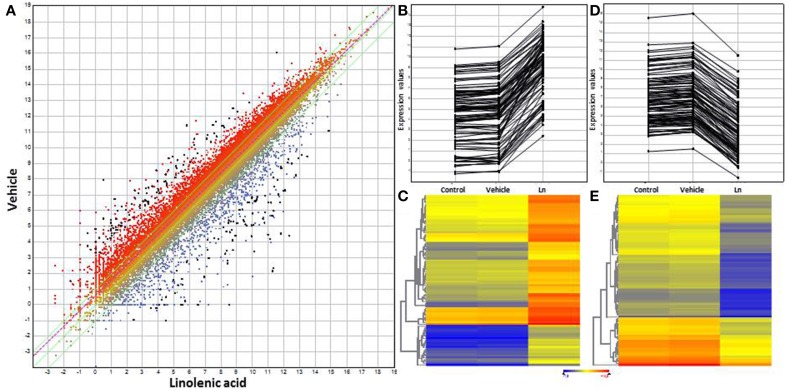
Scatter plot, line plot and heat map for 8-fold-change genes using DNAStar software. (A) Scatter plot of total Ln-responsive genes. (B) Line plot of overexpressed genes. (C) Heat map for overexpressed genes. (D) Line plot of repressed genes. (E) Heat map for repressed genes. Distilled water and methanol-responsive genes were used to filter the results of Ln treatment. All graphs show 8-fold-change genes with 95% significant differential expression obtained by t-student test from whole Ln-responsive genes.